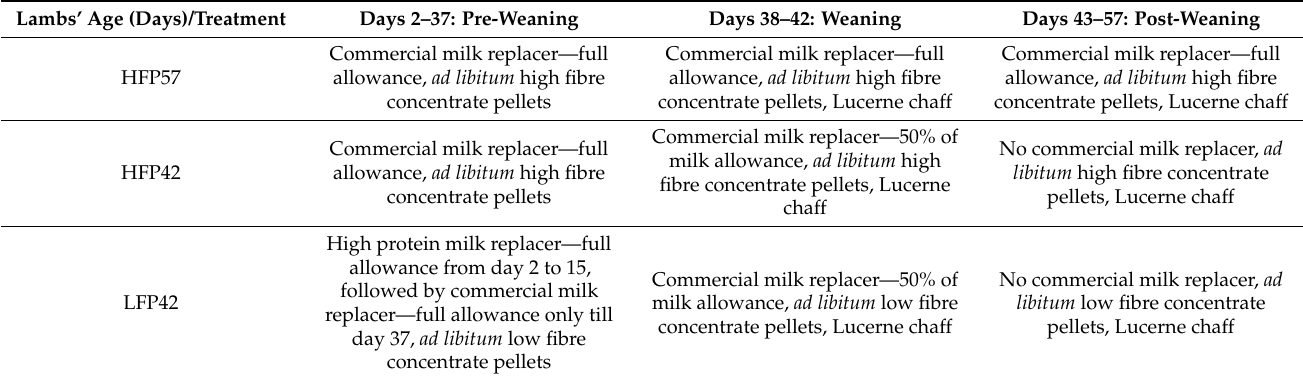
Table 1. Treatments and different phases of the